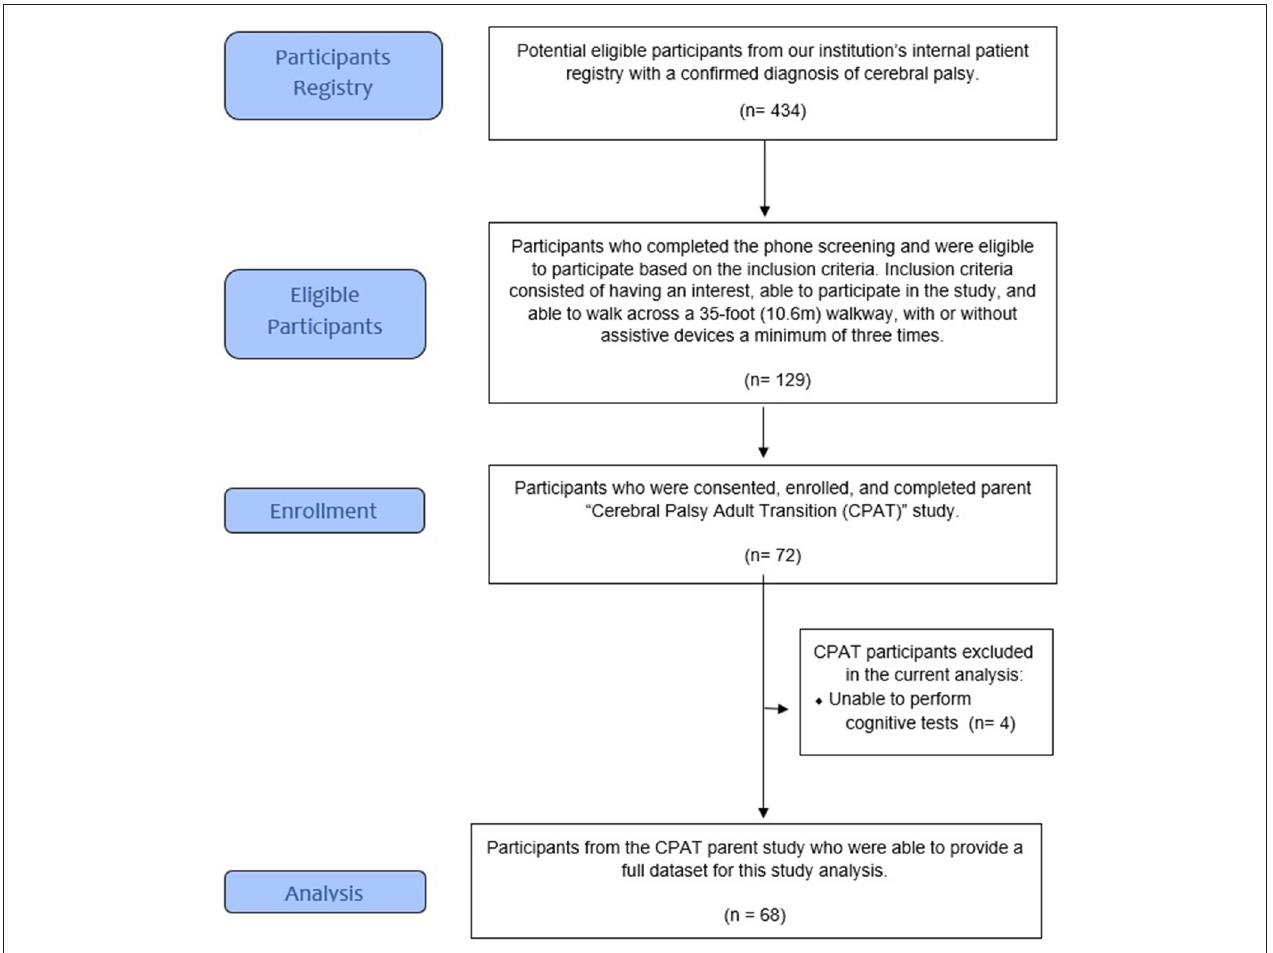
FIGURE 1 | Study participant flow